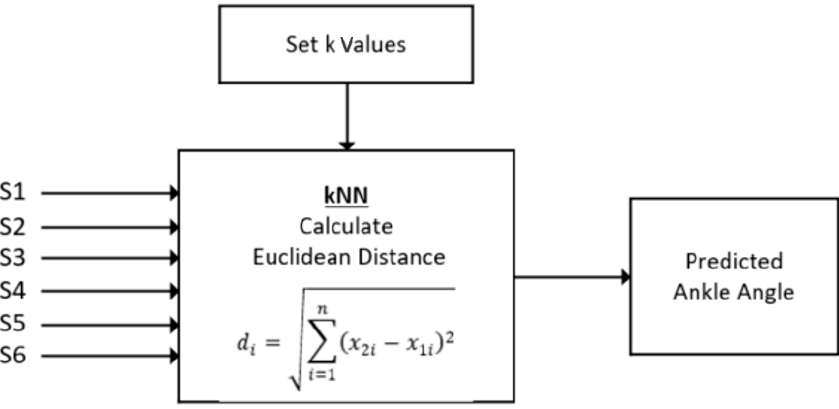
Figure 7. Block diagram of the kNN classification applied to this